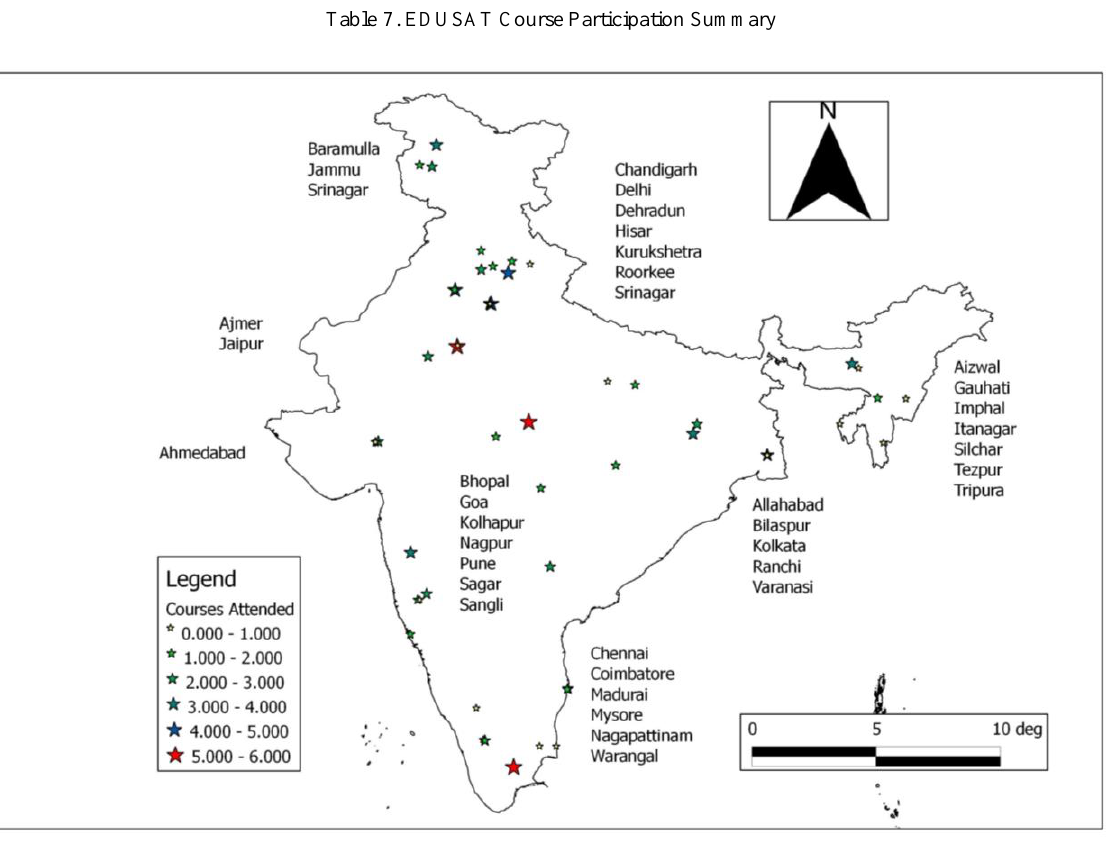
Figure 8. Distribution of Universities across